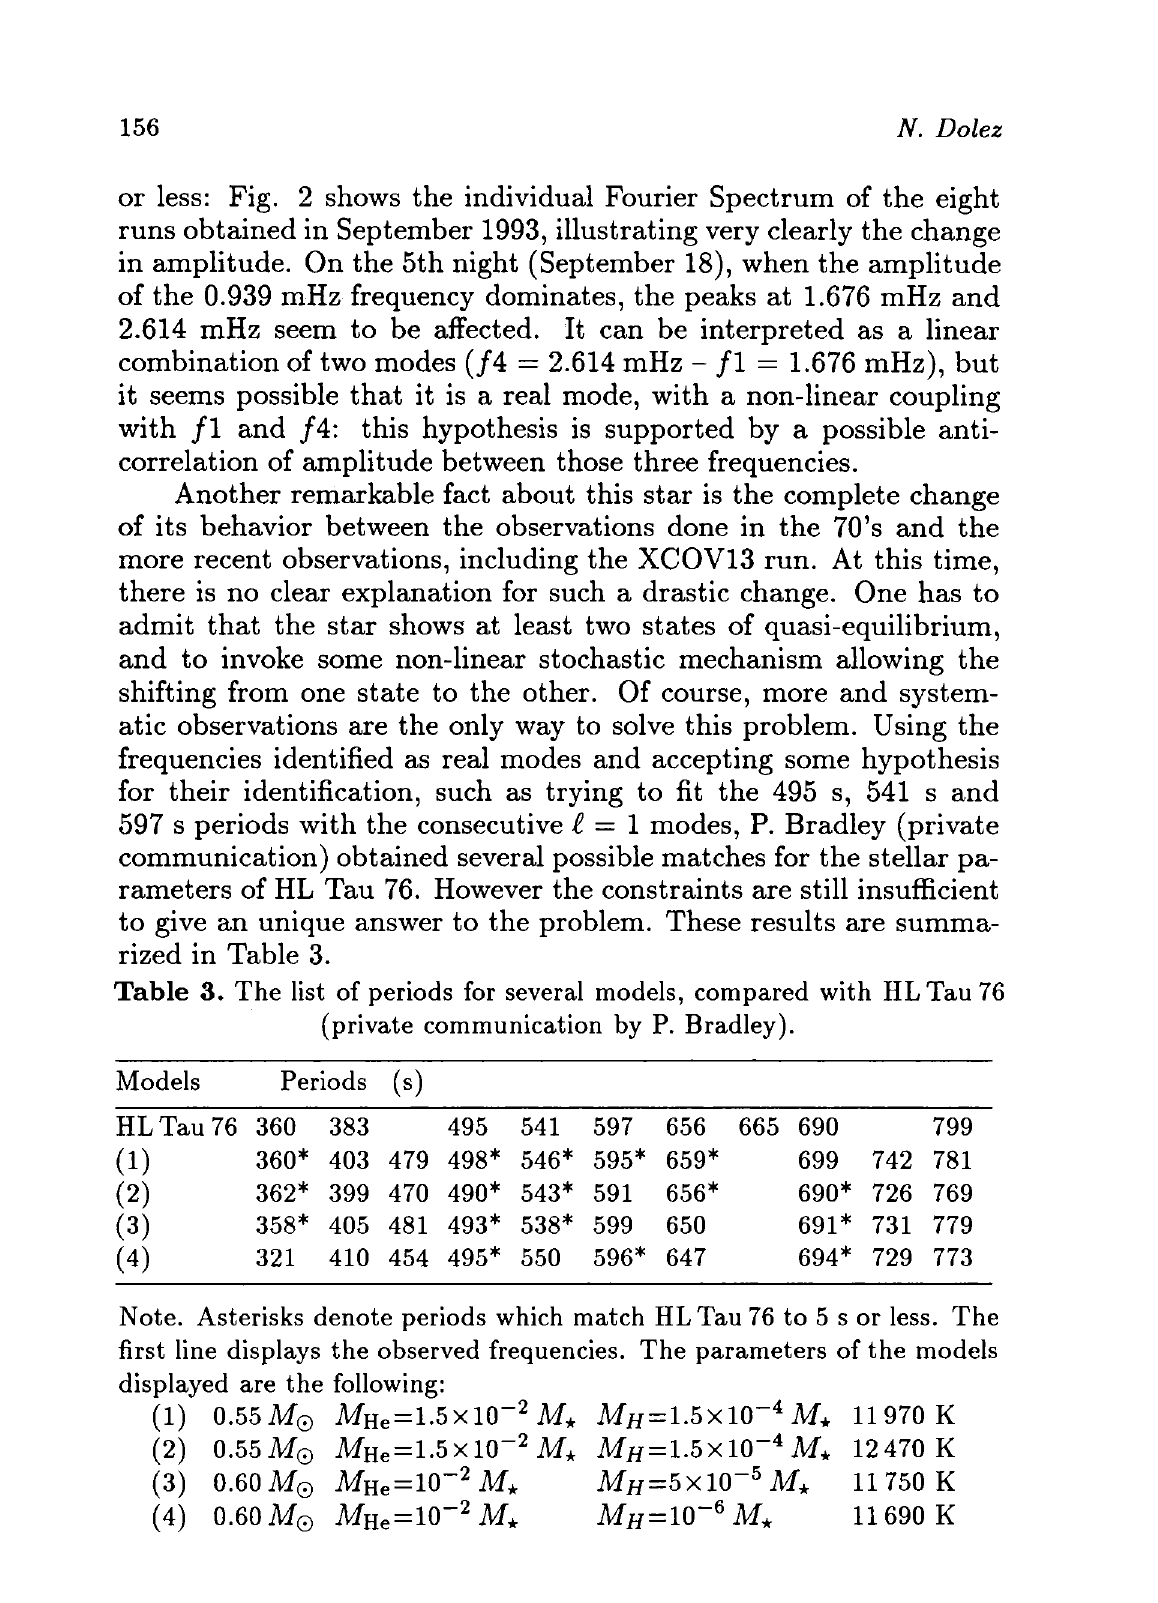
Table 3. The list of periods for several models, compared with HLTau 76 (private communication by P.